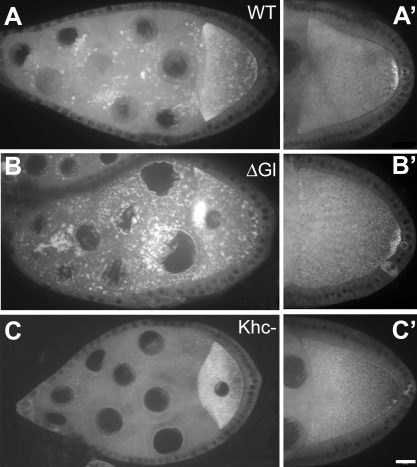
GFP-Imp Localization in the Oocyte Requires Microtubule Motor Function(A, A') GFP-Imp expression in wild type egg chambers is enriched in the oocyte and localizes to the posterior of the oocyte in stage 10.(B, B') Disruption of dynein using ΔGl overexpression (or the Dhc 6–6/6–12 transheterozygous mutant background; data not shown) produces an early aberrant accumulation of GFP-Imp to the oocyte anterior. However, the subsequent accumulation to the posterior pole is not affected.(C, C') In germline clones homozygous for the kinesin null mutation, khc27, GFP-Imp enrichment in the early oocyte is retained, but later accumulation at the posterior of the oocyte is lost. Bar (applies to all images), 10 μm.